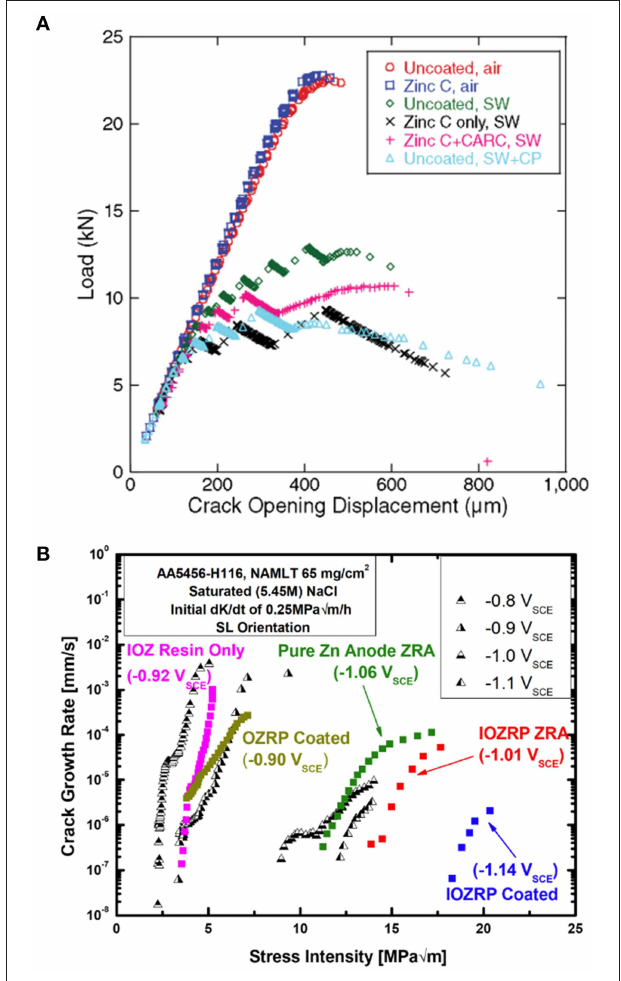
FIGURE 8 | The specific choice of primer type and design for protection of specific alloys is critical. For instance, Zn-rich primers applied on high strength steel cause hydrogen embrittlement rather than mitigate this phenomenon, as shown in (A) (Santucci et al., 2017a). When spray-coated on Al substrates, Zn-rich primers may effectively mitigate hydrogen embrittlement, but only when designed to achieve low polarizability, as demonstrated by the difference between the OZRP and IOZRP fracture mitigation results in (B) ( Santucci et al., 2018a). Reproduced with